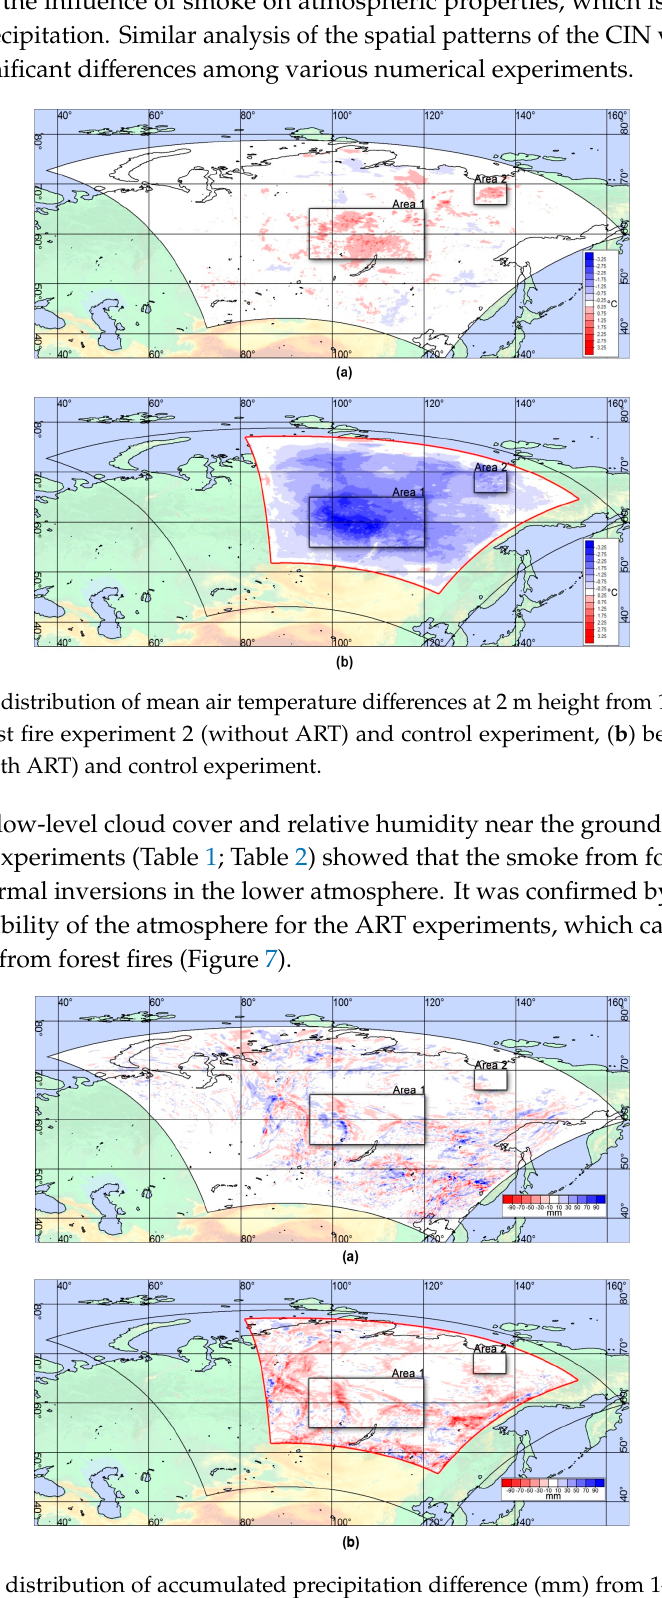
Figure 4. Modeled aerosol optical depth over the modeling domain, averaged from 1–14 August 2019.